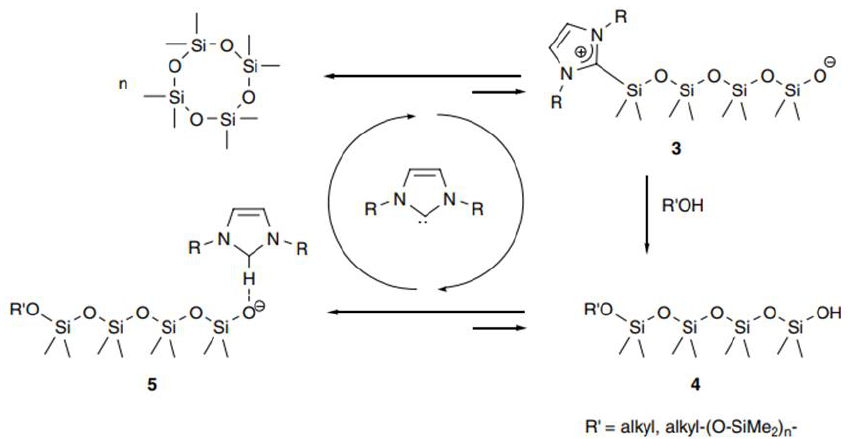
Figure 6. Proposed mechanism of ROP of D 4 (adapted with permission from Ref. [65]. 2007, Rodri- guez, M)